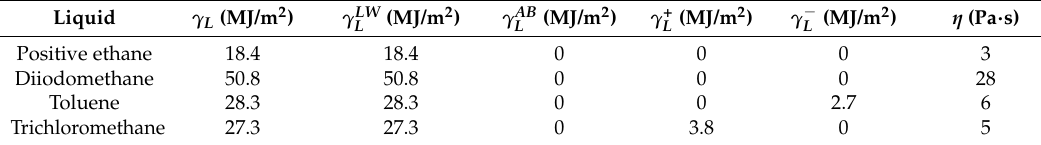
Table 2. Parameters of the reference liquids for determining fiber surface energy.